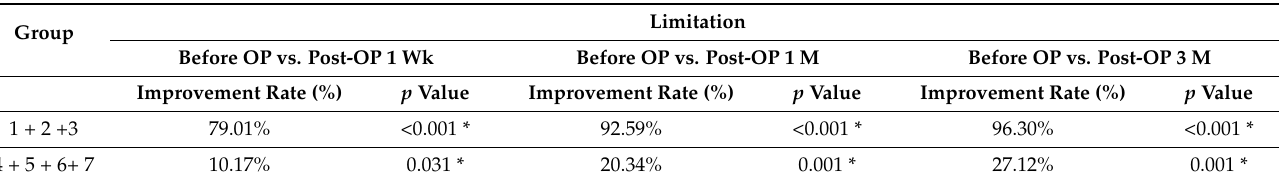
Figure 2. Comparison of EOM limitations between groups that received an operation within one week (1, 2, 3) and after more than one week (4, 5, 6, 7). The Mann – Whitney U test was used to compare between group (1 + 2 + 3) and group (4 + 5 + 6 + 7); EOM, extraocular movement; OP, operation; * p < 0.05. Table 3. The relationship of EOM limitation before and after the